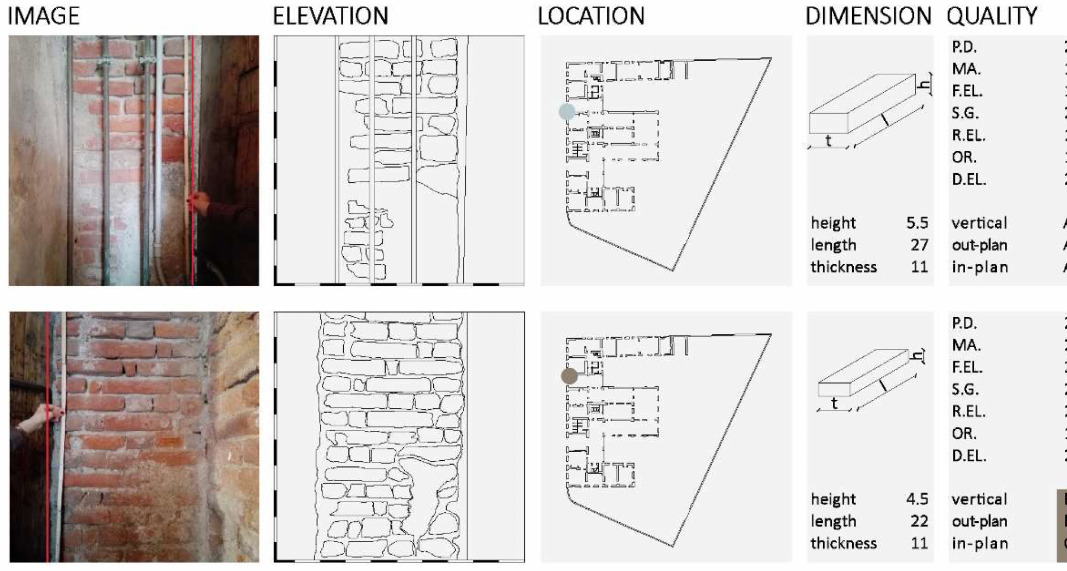
Figure 2. Identification of the masonry